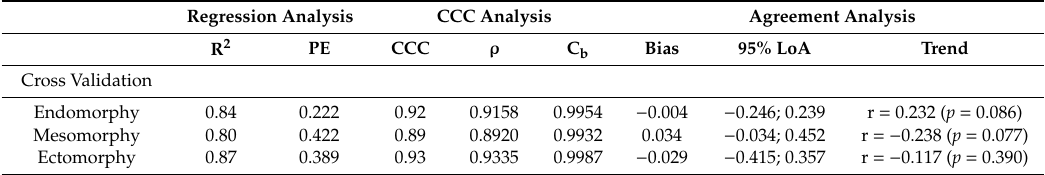
Table 3. Cross Validation of the Somatotype’s Predictive Models and the Reference